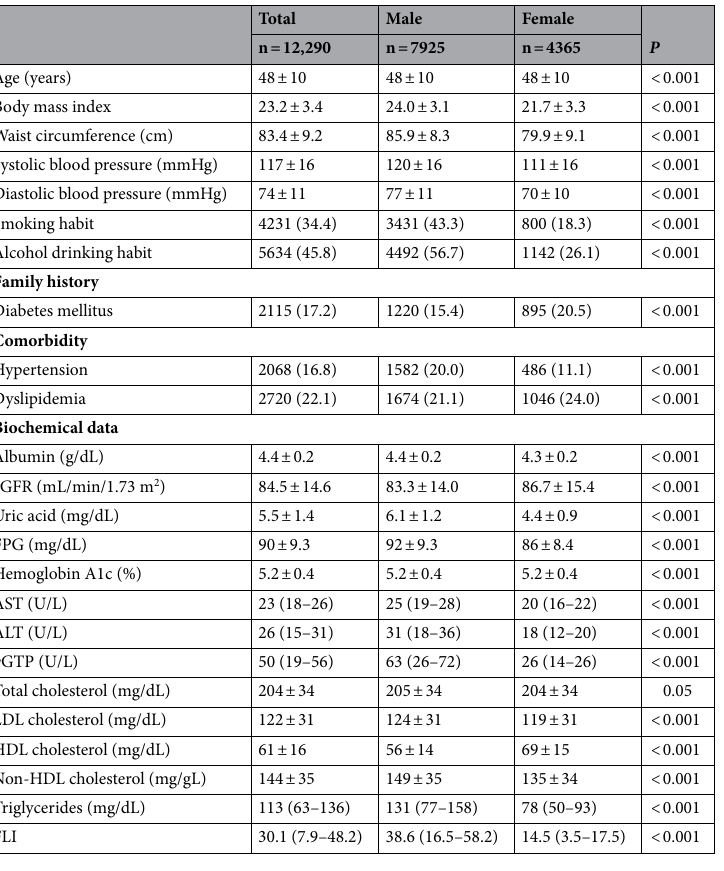
Table 1. Characteristics of the recruited subjects. Variables are expressed as number (%), means ± SD or medians (interquartile ranges). AST aspartate aminotransferase, ALT alanine aminotransferase,